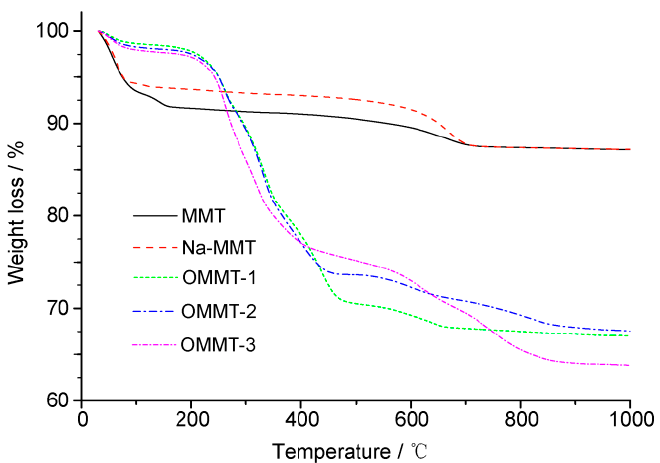
Figure 8. Thermogravimetric analysis (TGA) curves of the montmorillonite (MMT), Na-MMT, OMMT-1, OMMT-2, and OMMT-3 samples.